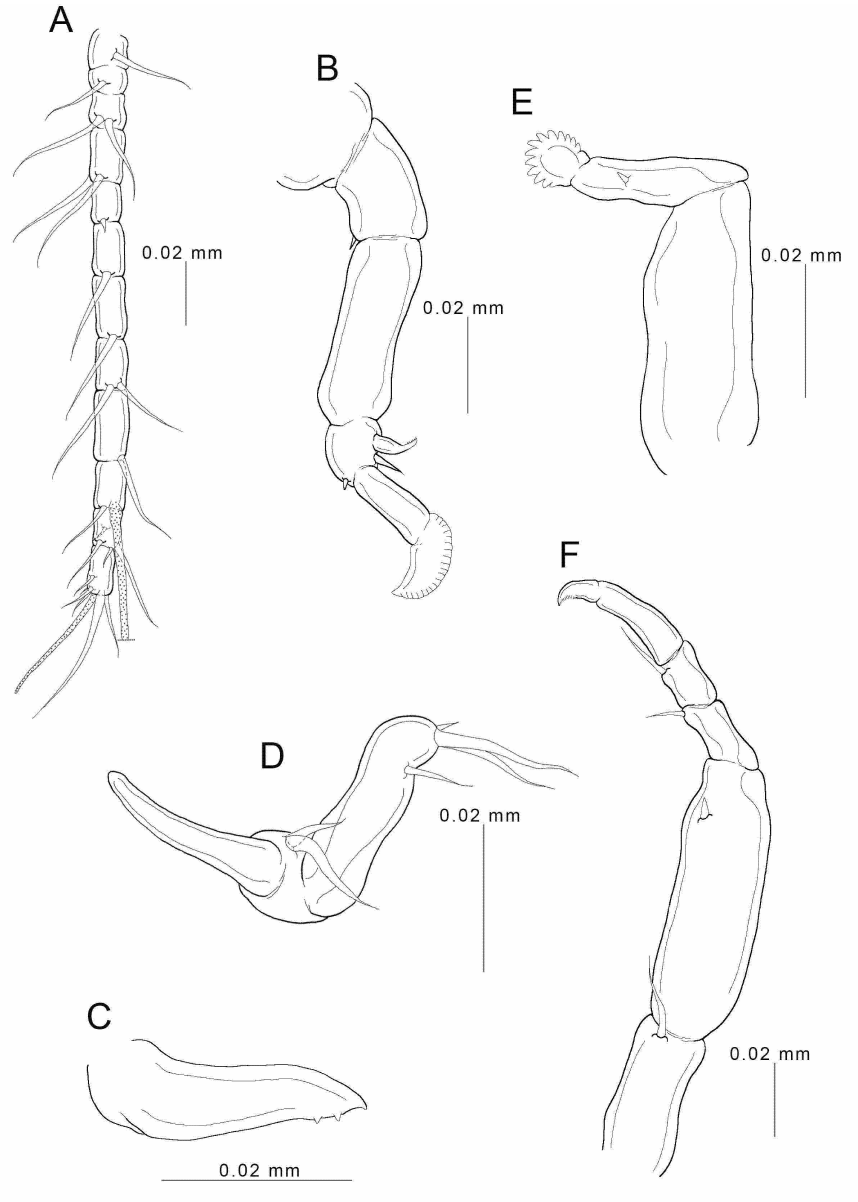
Figure 3. Female Choniomyzon taiwanensis n. sp. ( A ) Antennule; ( B ) antenna; ( C ) mandible; ( D ) max- illule; ( E ) maxilla; ( F ) maxilliped. Scale-bars: ( A , B , F ), 0.02 mm; ( C – E ), 0.01 mm. Legs 1 (Figure 5A) and 2 (Figure 5B,C) biramous, consisting of coxa, basis, and two- segmented rami; coxa unarmed; basis bearing one seta on each side, but leg 2 only with outer-side seta; both rami with spines and long plumose setae; armature formula of spines (in roman numerals) and setae (in arabic numerals) as